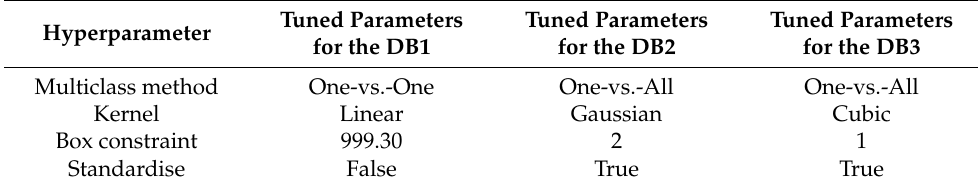
Table 2. Hyperparameters used for SVM classifiers with various